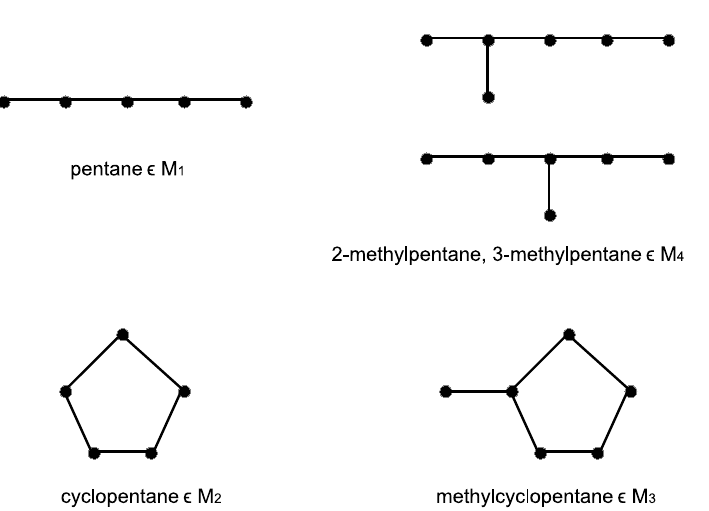
Figure 1. Representatives of each of four sets M 1 , . . . , M 4 .